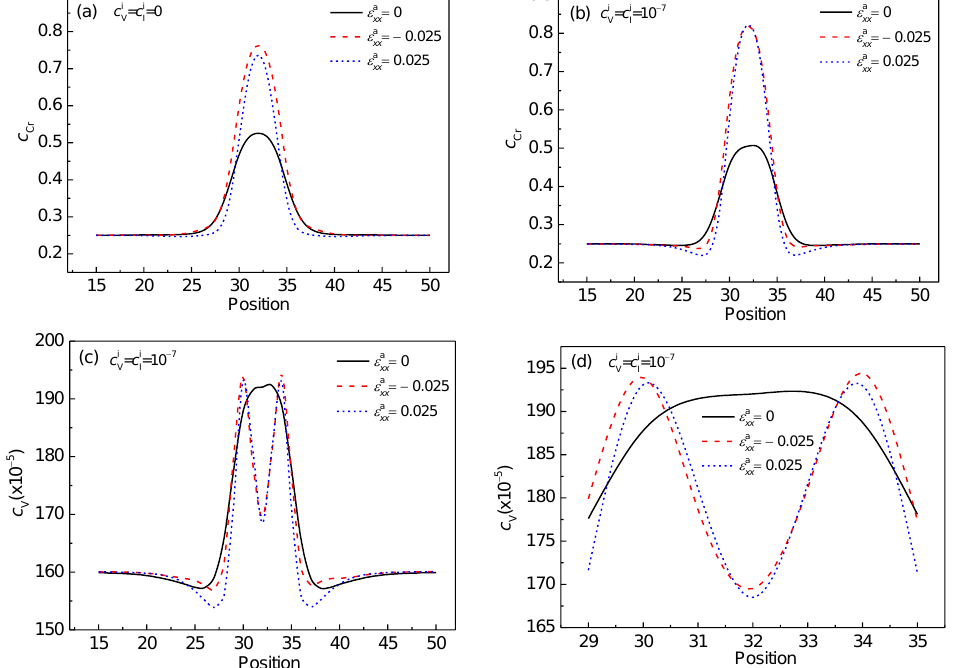
= c i = 0, ( b – d ) c i = c i = 1 × 10 − 7 , and V I V I